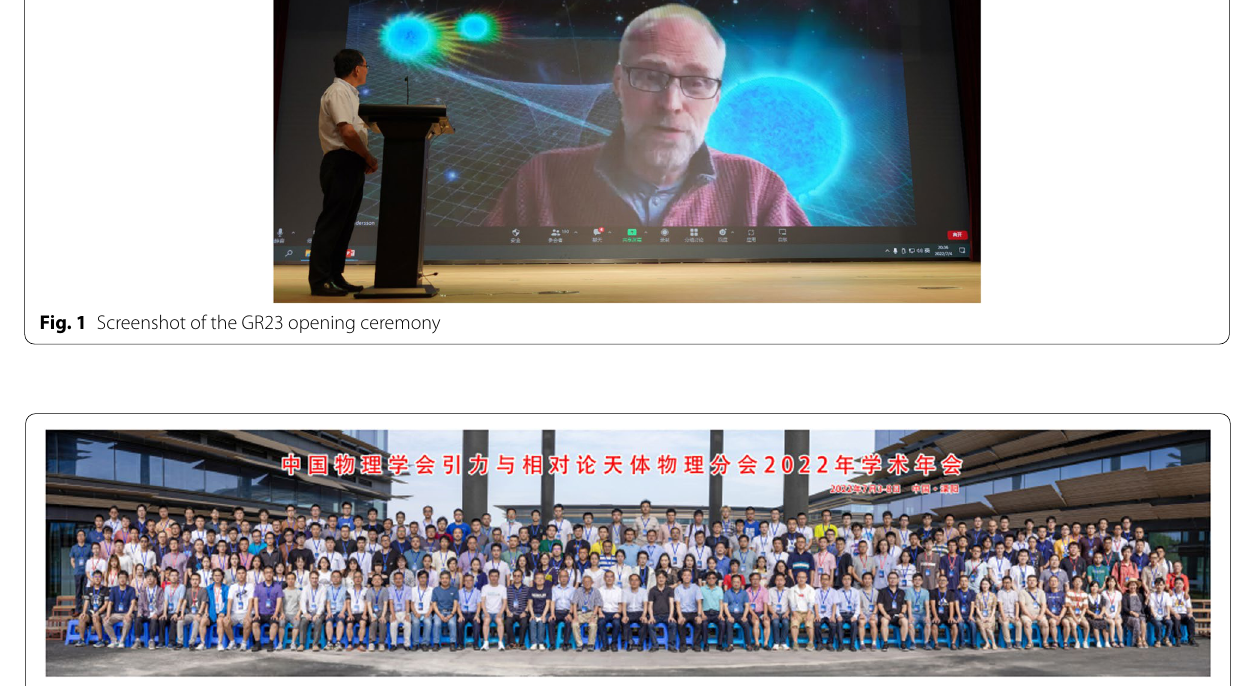
Fig. 2 Group photo of onsite